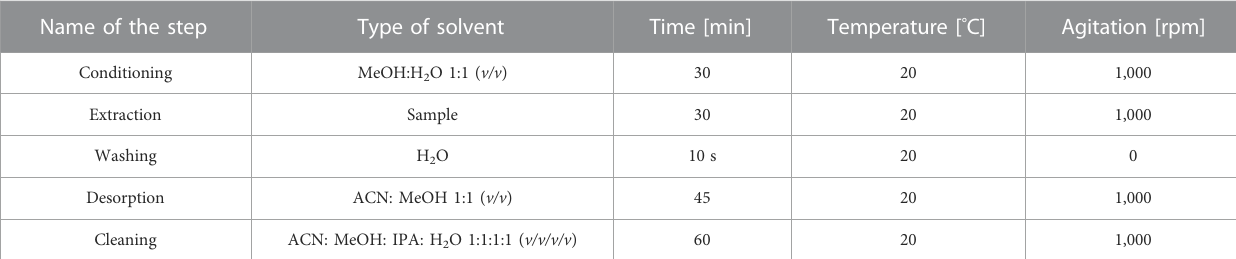
TABLE 2 Final conditions of developed and optimized TF-SPME method using PS-DVB sorbent for extraction of steroid-related compounds. Name of the step Type of solvent Time [min] Temperature [ ° C] Agitation [rpm]